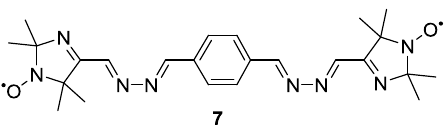
Figure 2. Imidazole-based